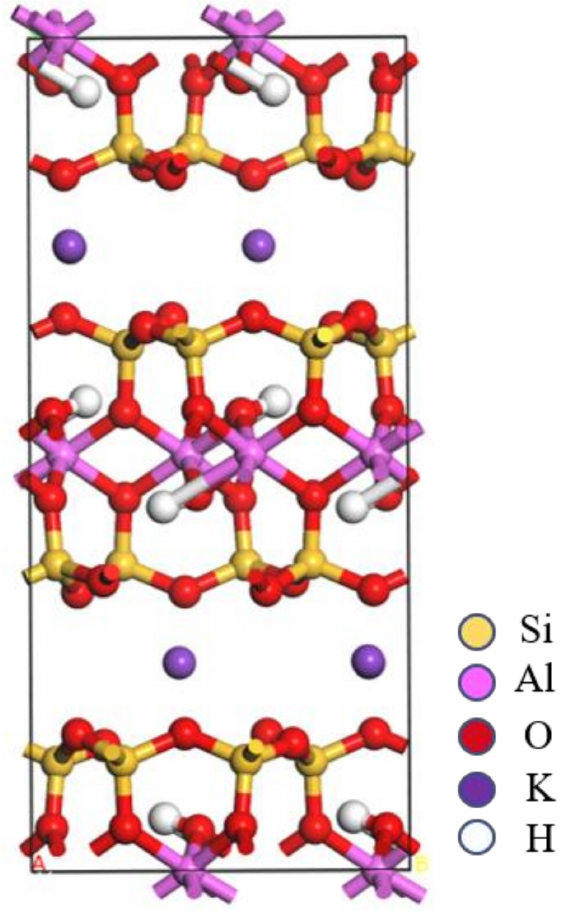
Figure 2. Original unit cell model of muscovite (the color of yellow, pink, red, purple, and white represents silicon, aluminum, oxygen, potassium, and hydrogen atoms, respectively).